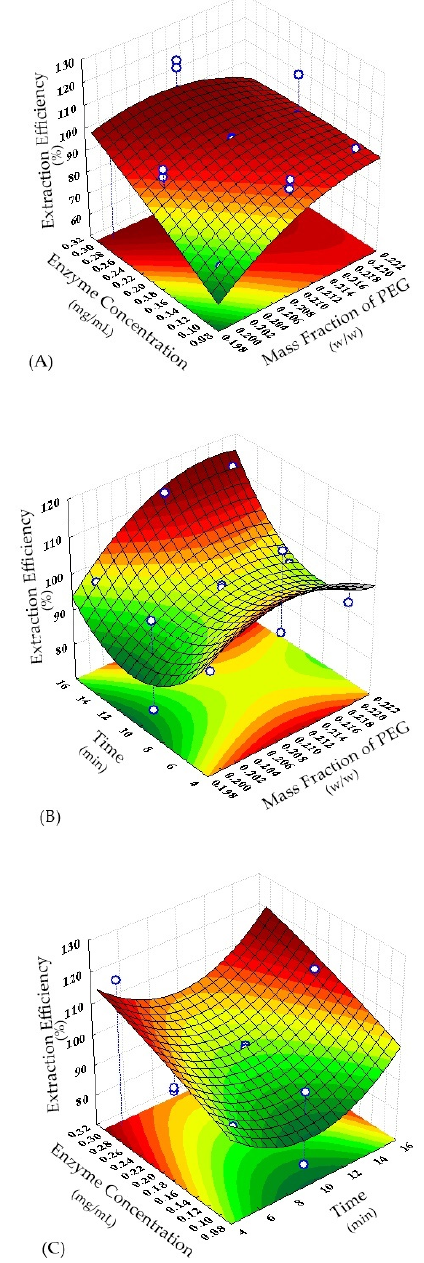
Figure 3. A 3D response surface plot showing the interaction effects of process variables (time, enzyme concentration, and mass fraction of PEG) on the extraction efficiency using ATPS with sodium citrate dihydrate. ( A ) enzyme concentration and mass fraction of PEG, ( B ) time and mass fraction of PEG, and ( C ) enzyme concentration and time.